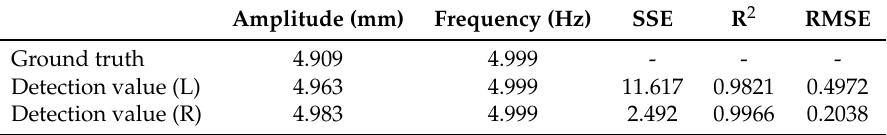
Figure 8. Experimental results for the amplitude in each translational direction: ( a ) X axis; ( b ) Y axis; ( c ) Z axis. Table 3. Fitting evaluation parameters of reconstruction results (movement in the Z axis).